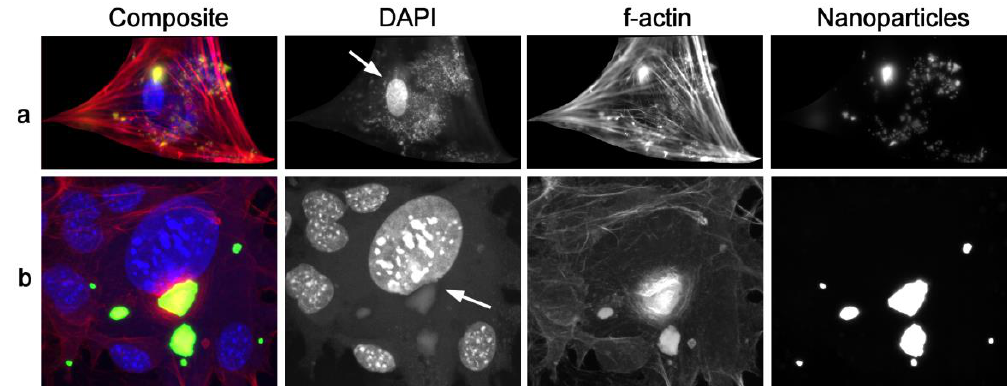
Figure 4. Fluorescent optical images of stained hMSCs and HAp nanoparticles. Both cells in the foci of images ( a ) and ( b ) display the uptake of finer nanoparticle aggregates, but also a single large agglomerate on the edge of the cell nucleus. Arrow in ( a ) points at the intact cell nucleus area overlapping with the nanoparticle agglomerate signal, while the arrow in ( b ) points at the indented